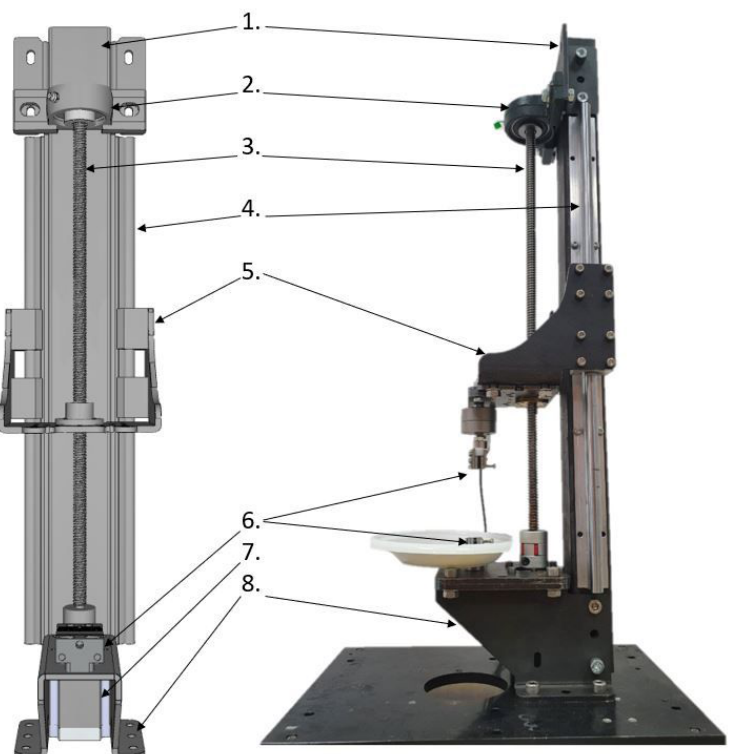
Figure 1. Assembly of SMT construction. 1. Main column, 2. bearing of a trapezoidal screw, 3. trapezoidal screw, 4. side guides cooperating with linear bearings from element (5), 5. mobile platform allowing for the installation of force sensors together with the jaw holder, 6. lower jaw holder, 7. stepper motor driving the trapezoidal screw, 8. base enabling the assembly of the station to the table.